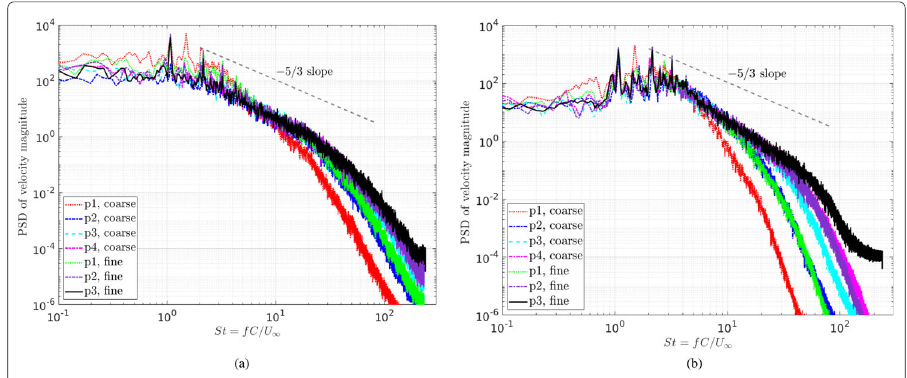
Fig. 8 Comparison of the PSD of the velocity magnitude for all cases at a wake point(1), b wake